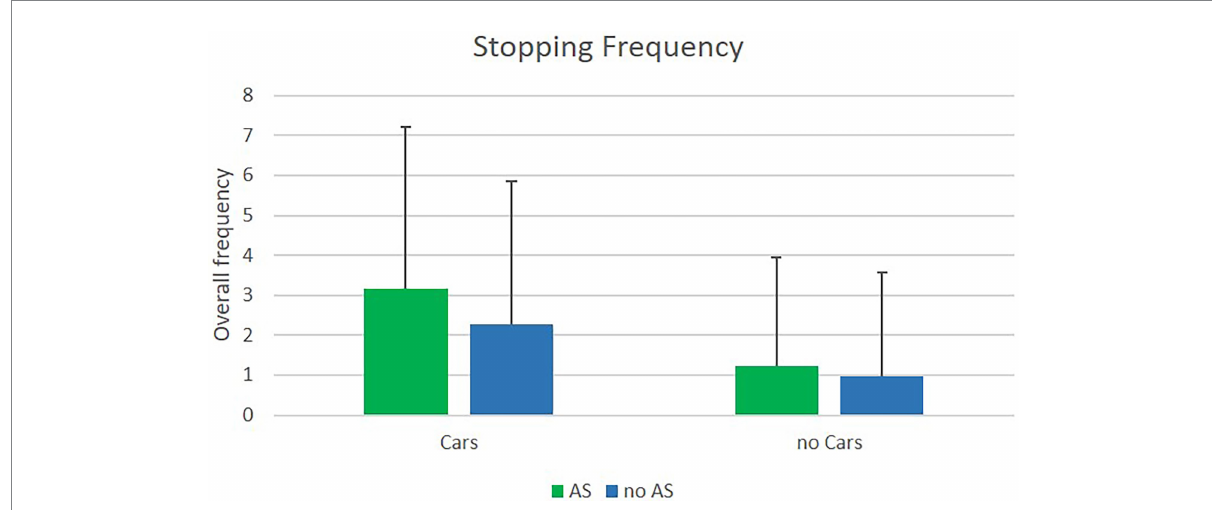
FIGURE 4 Means of stopping frequencies in the VR experiment with and without cars, with (AS) and without (nAS) the assistance system.